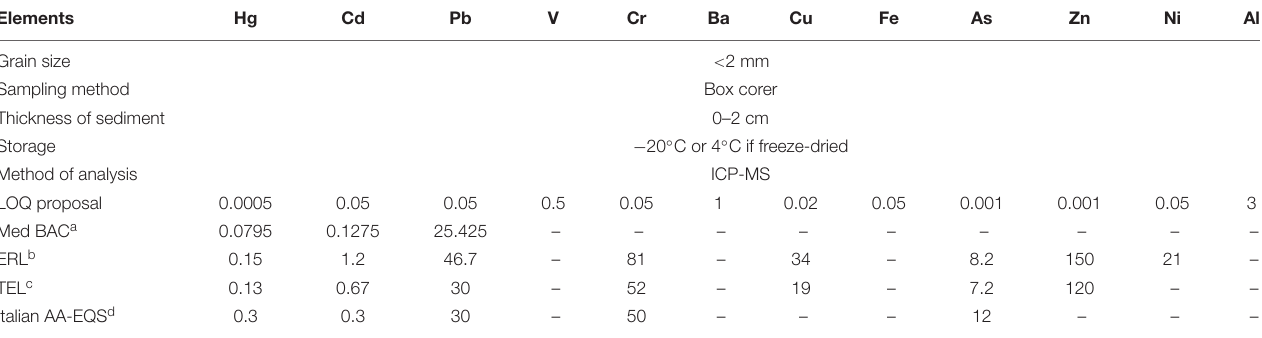
TABLE 5 | Proposed harmonized monitoring procedures of metals in sediment. LOQ values and international reference thresholds are expressed as mg/kg d.w. Elements Hg